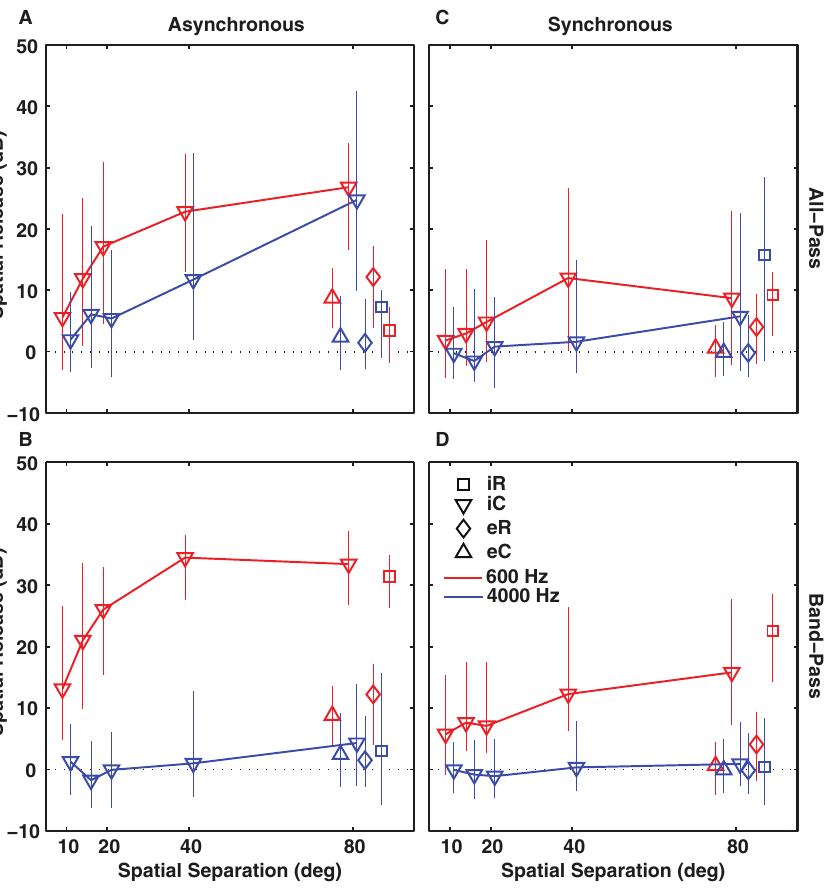
Figure 5. Spatial release from masking as a function of spatial separation between signal and masker. We obtained spatial release by subtracting detection thresholds for all spatial configurations from the S0M0 thresholds. Spatial release for the 600-Hz signal and the 4000-Hz signal are plotted in red and blue, respectively. Squares and diamonds represent iR and eR masker data, downwards and upwards pointing triangles iC and eC maskers, respectively. Data for the all-pass masking backgrounds are shown in panels A and C, band-pass data in panels B and D. Results for the asynchronous and synchronous timing conditions are plotted in panels A, B and C, D, respectively. Error bars indicate 25 th and 75 th percentiles. Note that for a given timing condition the same energetic backgrounds are replotted in the corresponding all-pass and band-pass panels. Frequencies for the energetic backgrounds per definition always fall within the protected-band rendering a distinction in all-pass and band-pass impossible.